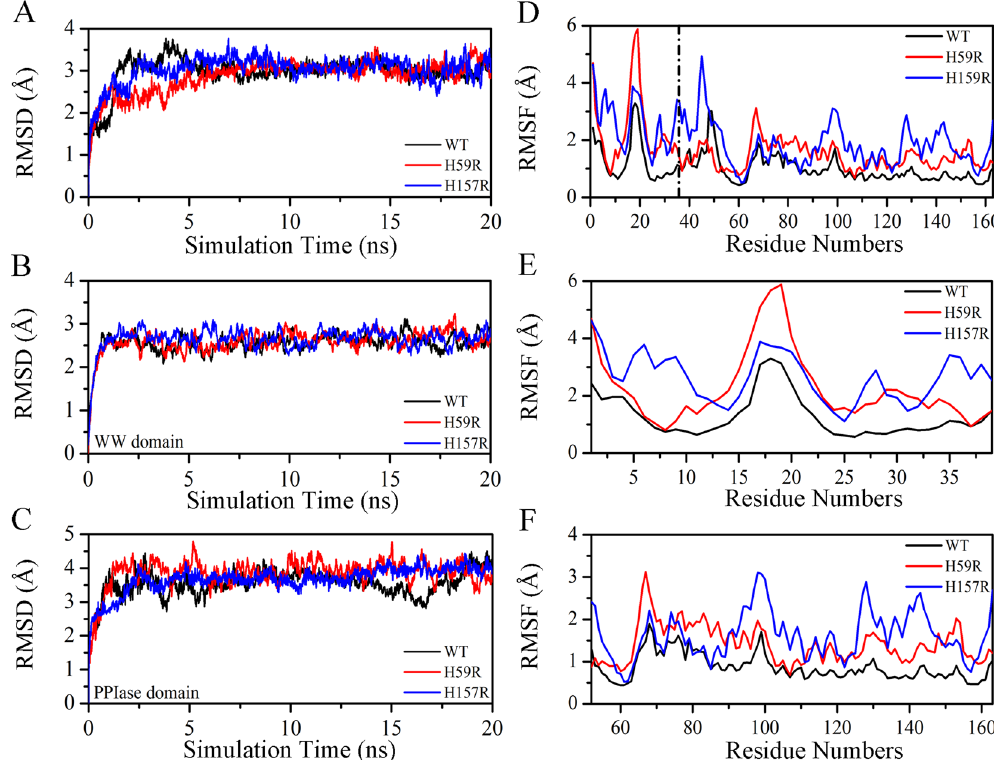
Figure 7. The RMSD and RMSF results in Pin1-WT, H59R and H157R as a function of 20 ns MD simulation. ( A – C ) Represent C α - RMSD of the overall structure, PPIase and WW domain, respectively. ( D , E ) Represent C α - RMSF of the overall structure, PPIase and WW domain, respectively.